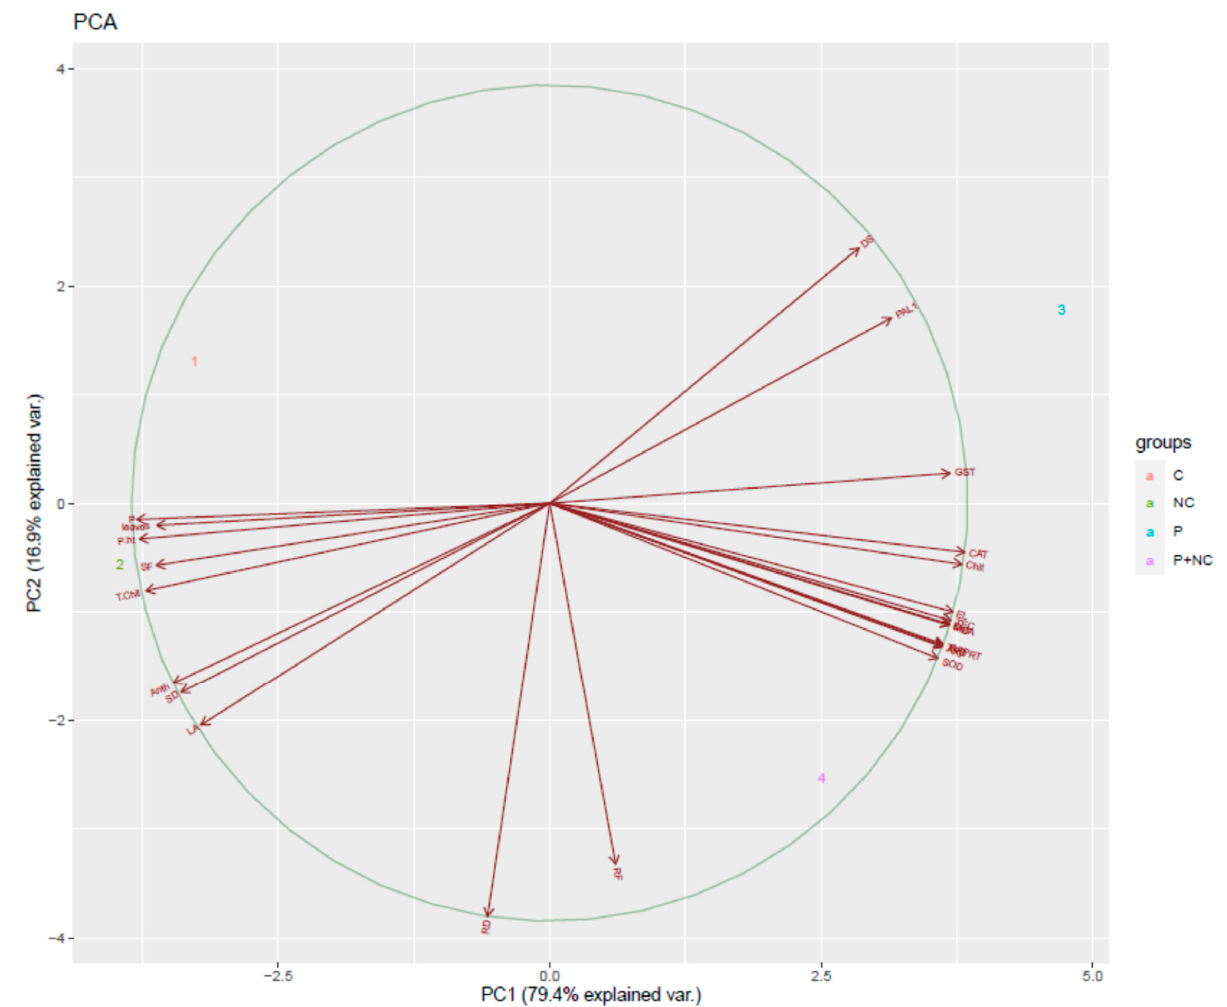
Figure 7. Principal component analysis (PCA) of plant grown under different treatments.